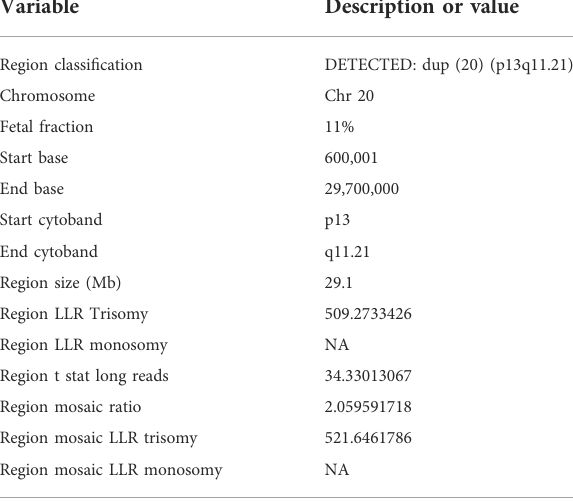
TABLE1NIPTresultindicatingapericentromeric29 Mbduplicationof chromosome 20: dup (20) (p13q11.21).